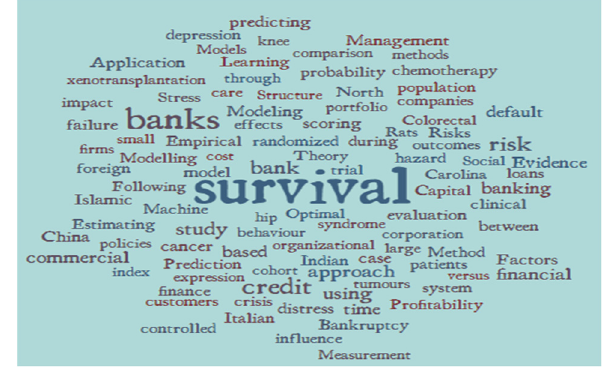
Figure 2: Word cloud of the